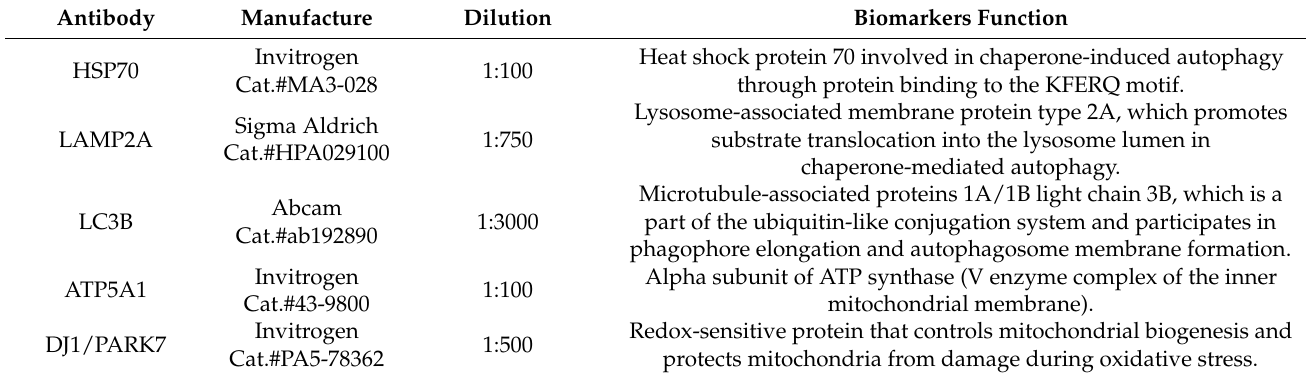
Table 2. Characteristics of primary